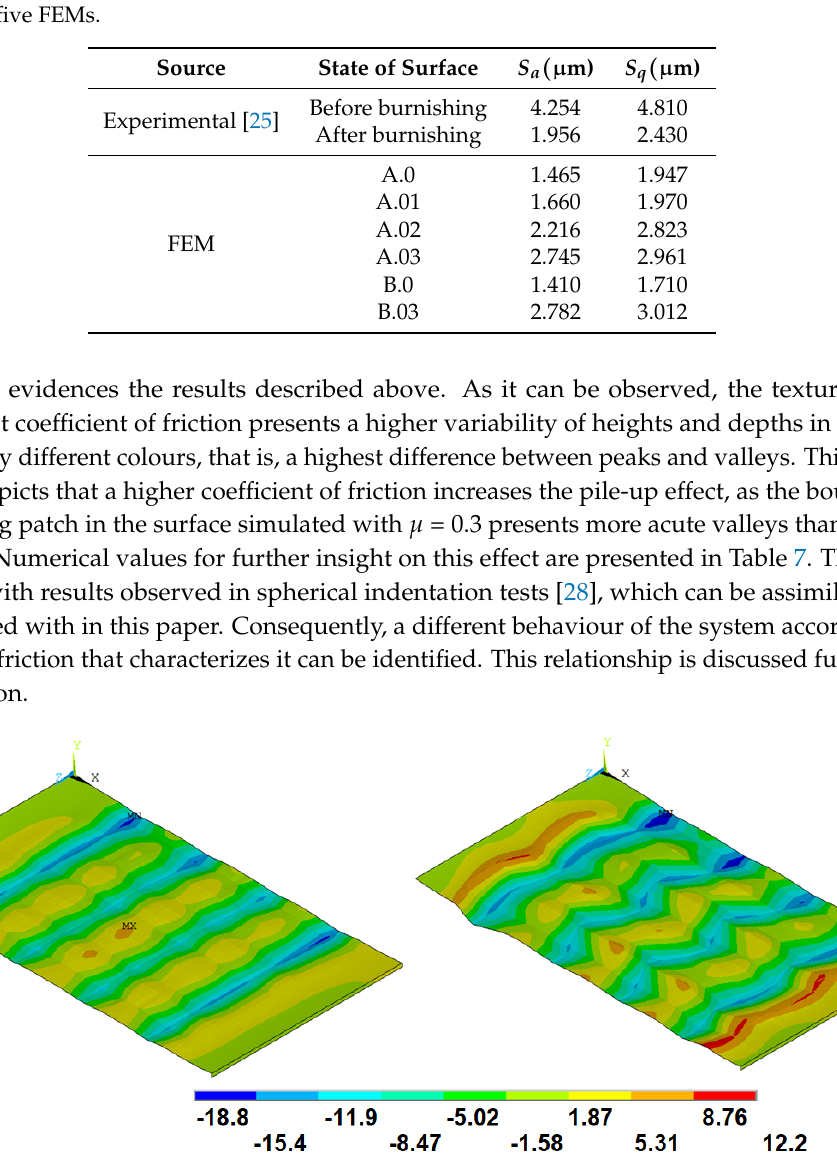
Figure 7. Surface topology after simulation ( µ m). Left . µ = 0. Right . µ =